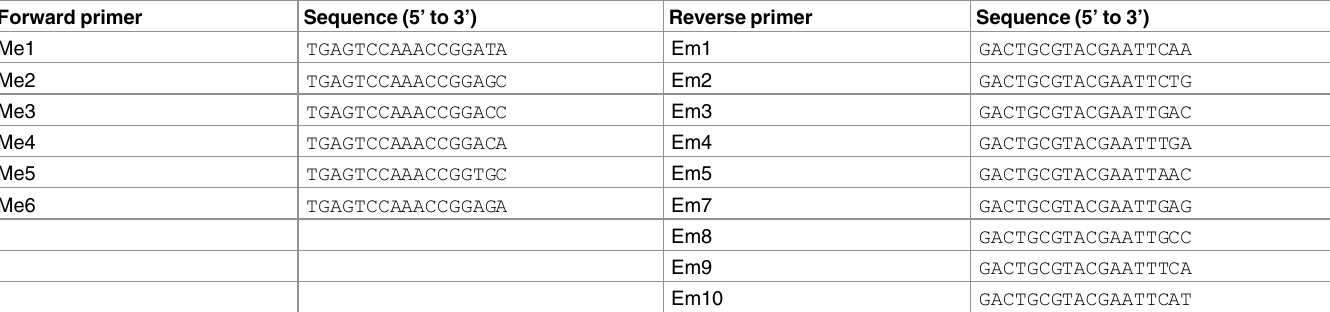
Table 2. Sequence-related amplified polymorphism (SRAP) primers used to detect